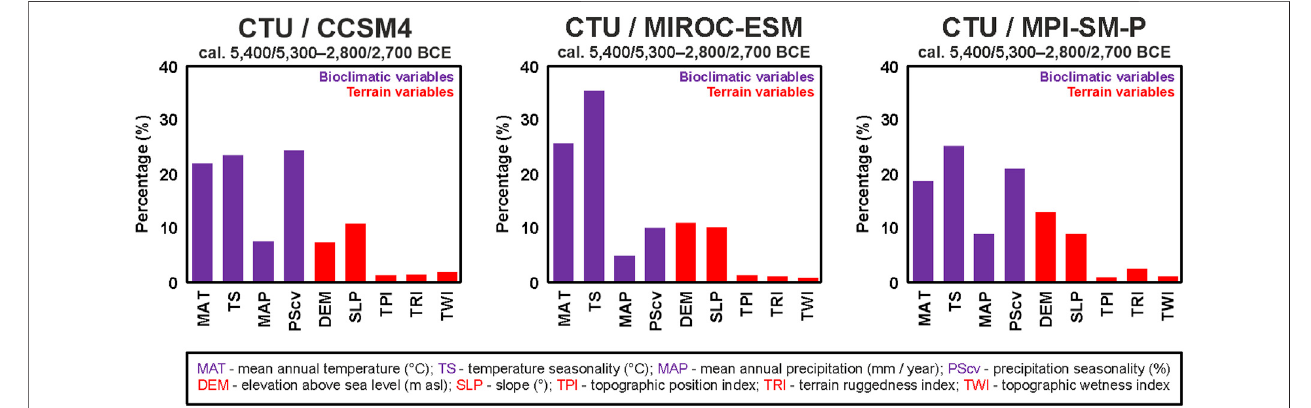
FIGURE 6 | Variable contributions to CTU niches reconstructed using bioclimatic variables derived from CCSM4, MIROC-ESM, and MPI-ESM-P global climatic models (GCM) and DEM-derived terrain variables.